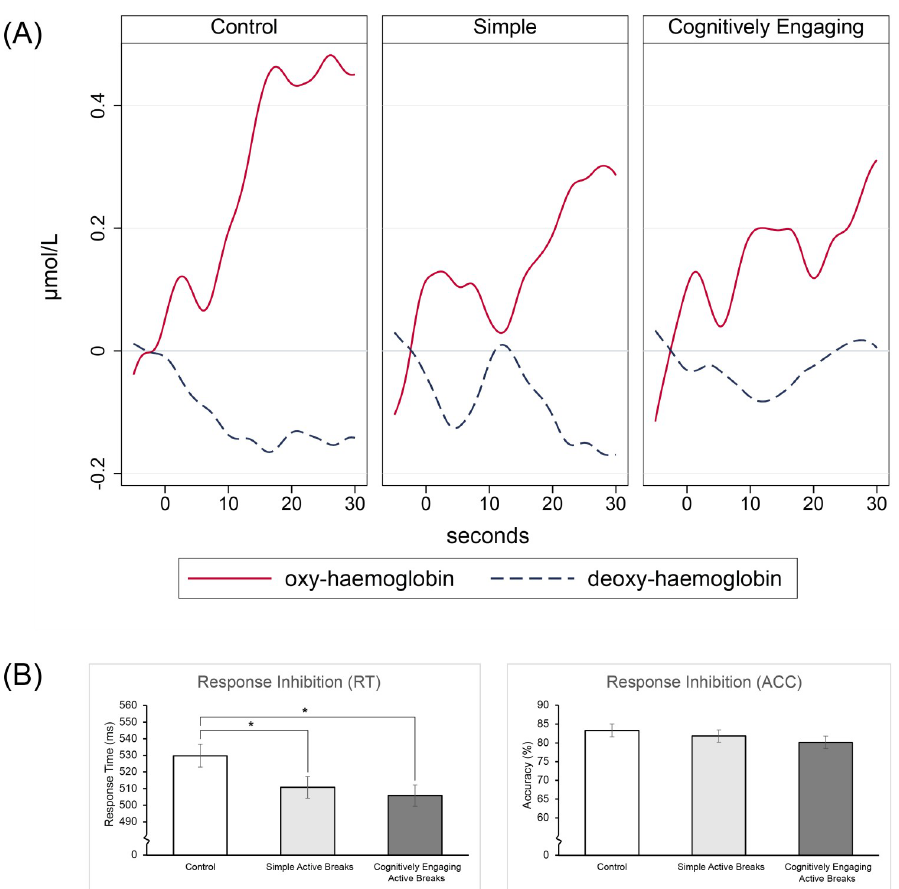
Fig 3. Left dorsolateral prefrontal cortex haemodynamic response and related cognitive performance at the end of trial. ( A ) Unadjusted average haemodynamic response (oxy- and deoxy-) during a Go/No-Go task at the end of trial by study group; ( B ) Performance at the Go/No-go task completed during the fNIRS assessment; group marginal means ± standard error calculated following linear mixed models adjusted for the baseline performance at the task, sex, age, and for the random effects of classroom as a clustering variable. Note that lower response time (RT) and/or higher accuracy (ACC) are indicative of better performance at the cognitive